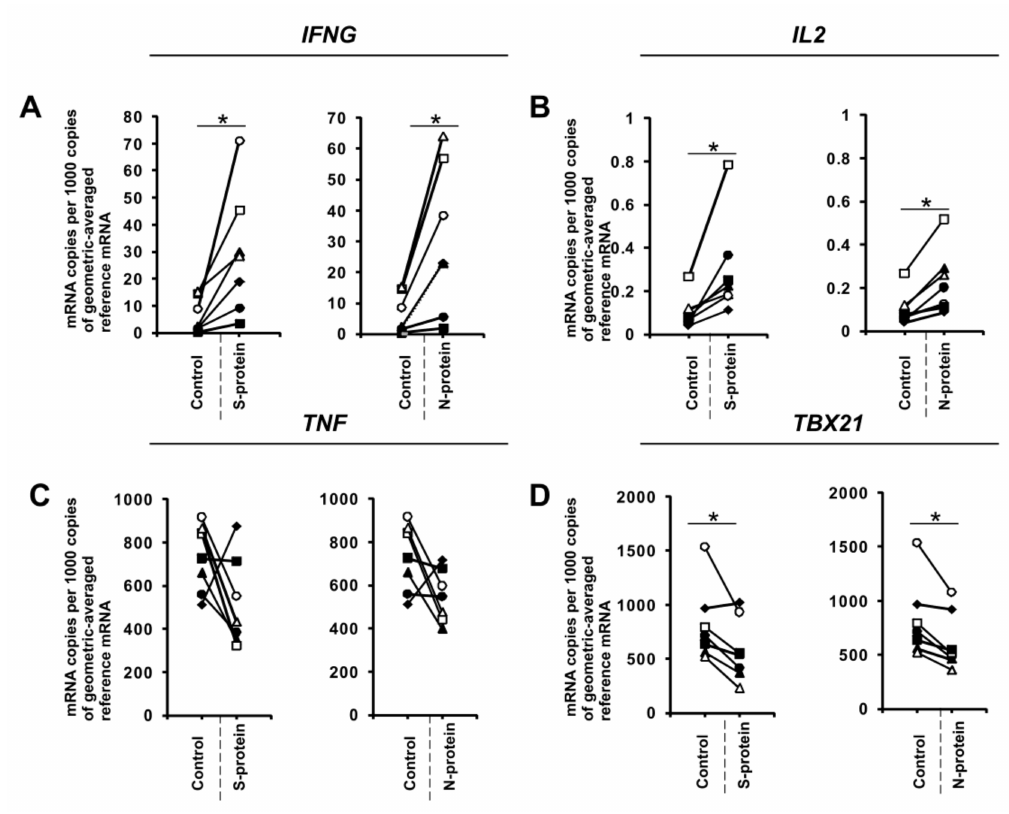
Figure 1. SARS-CoV-2 proteins mediate gene expression in CD4 + cells isolated from healthy, unexposed donors that were di ff erentiated into Th1 lymphocytes. mRNA expression of IFNG ( A ), IL2 ( B ), TNF ( C ), and TBX21 ( D ) genes in CD4 + cells di ff erentiated towards Th1 cells in the presence of 1 µ g / mL SARS-CoV-2 proteins S (spike) and N (nucleocapsid) for 5 days determined by real-time RT-PCR and normalized to averaged reference mRNA levels of the housekeeping genes HPRT1 , HMBS , and RPL13A . Data show individual values for seven independent donors ( n = 7). “Control” denotes cells cultured in the absence of SARS-CoV-2 proteins for 5 days, and “S-protein” or “N-protein” denotes cells cultured in the presence of SARS-CoV-2 protein (S or N, respectively) for 5 days. Control values are the same for both conditions (S and N proteins). Straight lines connecting two points (control and given protein) identify samples from a specific donor. An asterisk indicates a statistically significant di ff erence at p < 0.05. Statistical analysis was performed using Friedman repeated measures ANOVA on ranks followed by Student–Newman–Keuls post hoc